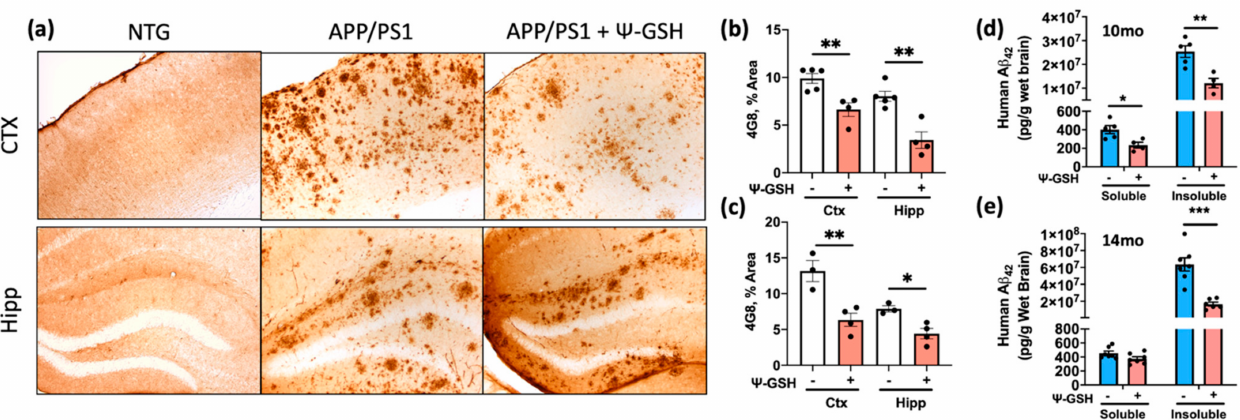
Figure 3. ψ -GSH treatment reduces A β burden in symptomatic 10-mo-old APP/PS1 mice. ( a ) Representative images of A β plaques visualized using 4G8 antibody in S1BF cortex and dentate gyrus of 14-mo NTG and APP/PS1 mice. Scale bar, 100 µ m; ( b ) levels of A β plaques are significantly reduced in S1BF and hippocampus in ψ -GSH-treated 10-mo APP/PS1 mice ( n = 5 APP/PS1 + Saline; n = 4 APP/PS1 + ψ -GSH); ( c ) levels of A β plaques are significantly reduced in S1BF and hippocampus in ψ -GSH-treated 14-mo APP/PS1 mice ( n = 3 APP/PS1 + Saline; n = 4 APP/PS1 + ψ -GSH); ( d , e ) quantitation of the effect of ψ -GSH treatment on amyloid load in APP/PS1 mice using ELISA assay. Levels of insoluble A β 1–42 levels in the brain homogenate of mice treated with ψ -GSH were significantly reduced in both 10-mo ( d ) and 14-mo ( e ) cohorts. For comparisons between saline and ψ -GSH-treated APP/PS1 groups ( b , c ), an unpaired Student’s t -test was performed for statistical analysis. * p < 0.05, ** p < 0.01, *** p <